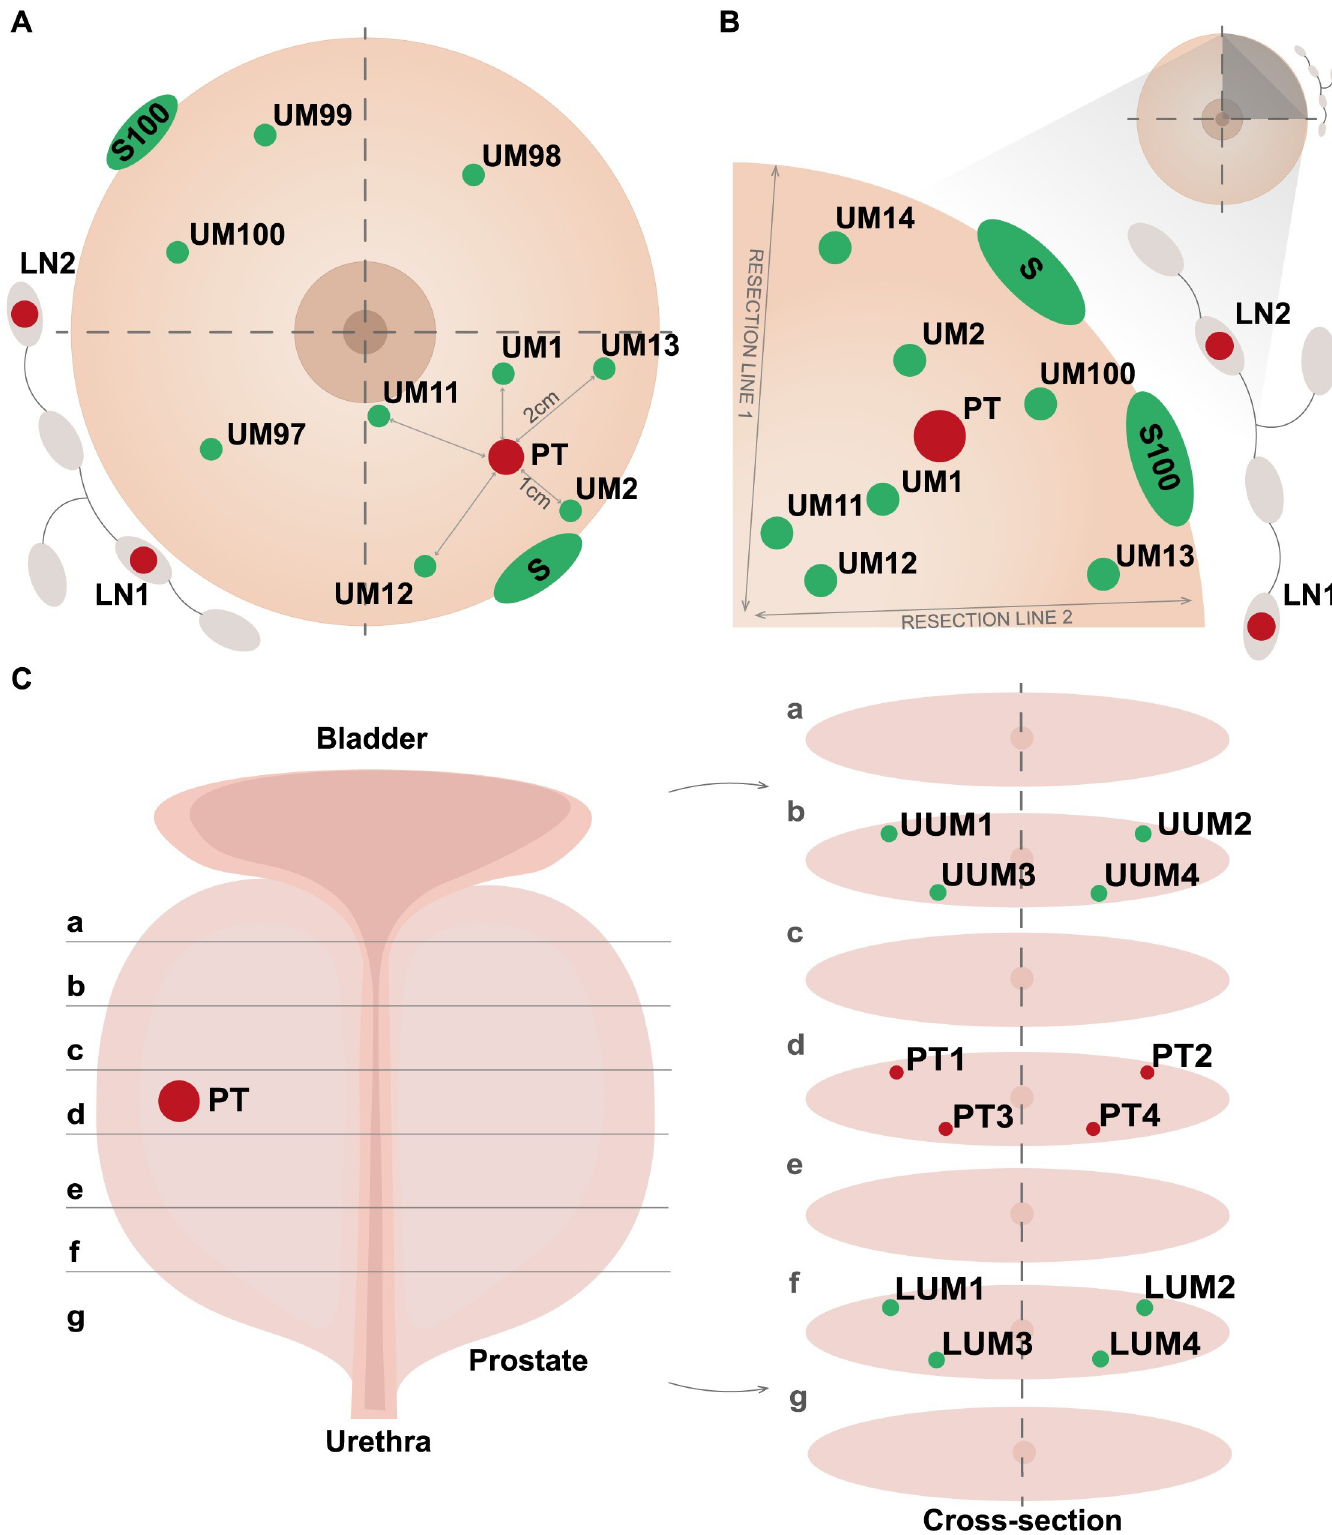
Fig 2. An illustration of sample collection protocols for breast- and prostate cancer. (A) Procedure for breast carcinoma samples treated with mastectomy. (B) Procedure for breast carcinoma patients treated with Breast Conservative Therapy (BCT). The distances in centimeters between samples of primary tumor and normal